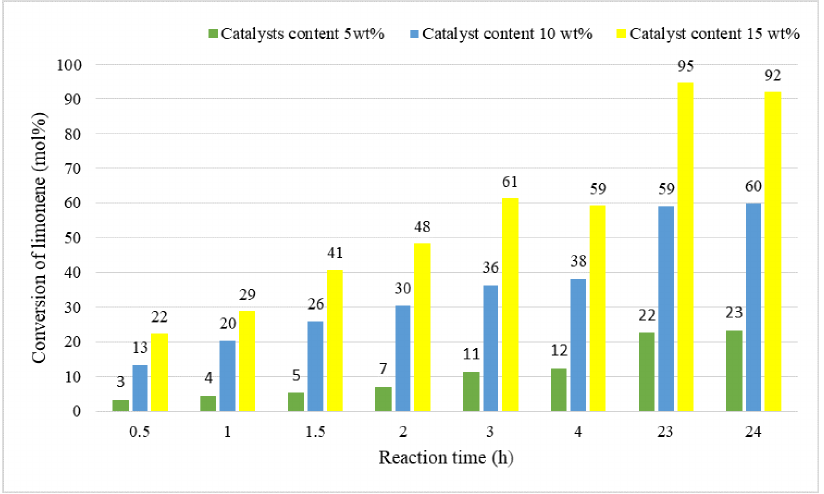
Figure 3. The influence of the catalyst content (10 wt% or 15 wt%) on the conversion of limonene for the reaction carried out at a temperature of 170 ◦ the reaction carried out at a temperature of 170 ° C.